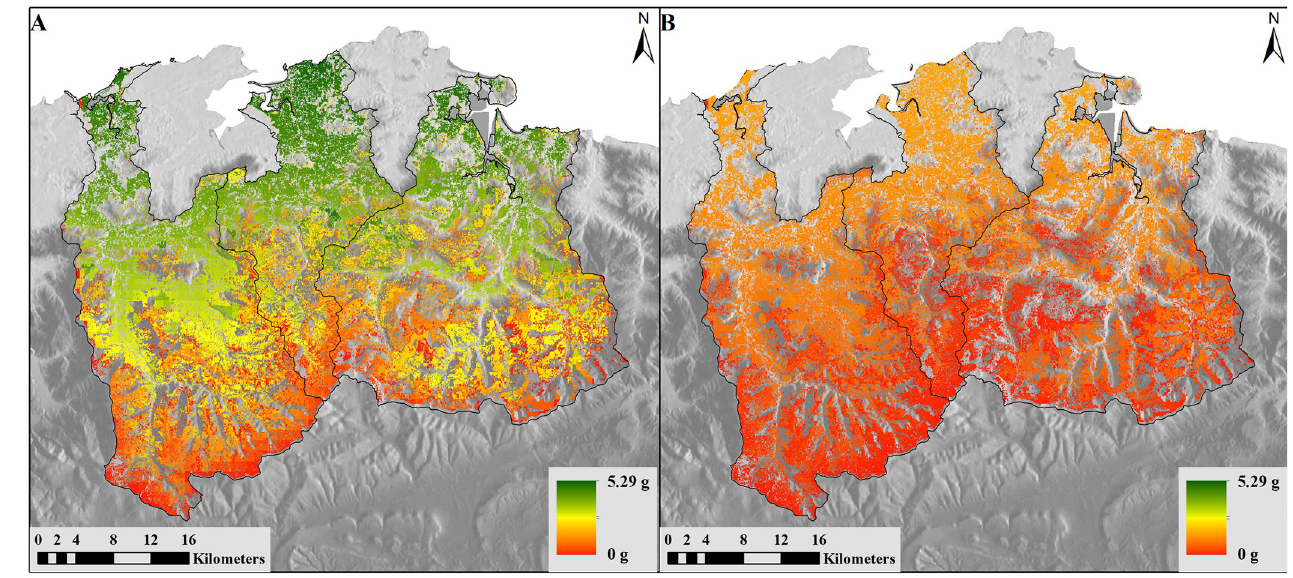
Fig 7. Modelled results of vegetation growth. (A) Potential Growth causing AboveGround Biomass model in grams/day and (B) Growth causing AboveGround Biomass model in grams/day (Cantabrian case study, May 2018). Reprinted from [67] under a CC BY license, with permission from ISPRS Journal of Photogrammetry and Remote Sensing, original copyright